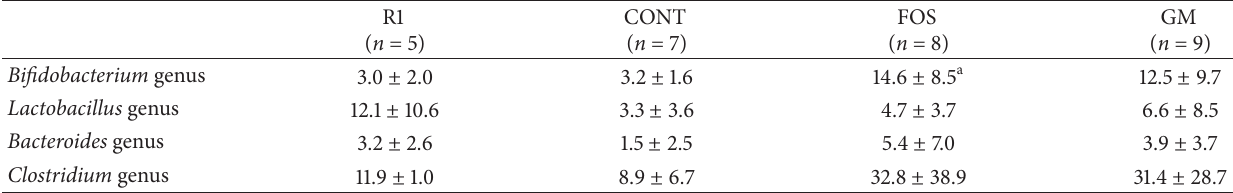
Table 3: Profiles of bacterial count in cecal at 38 weeks of feeding.